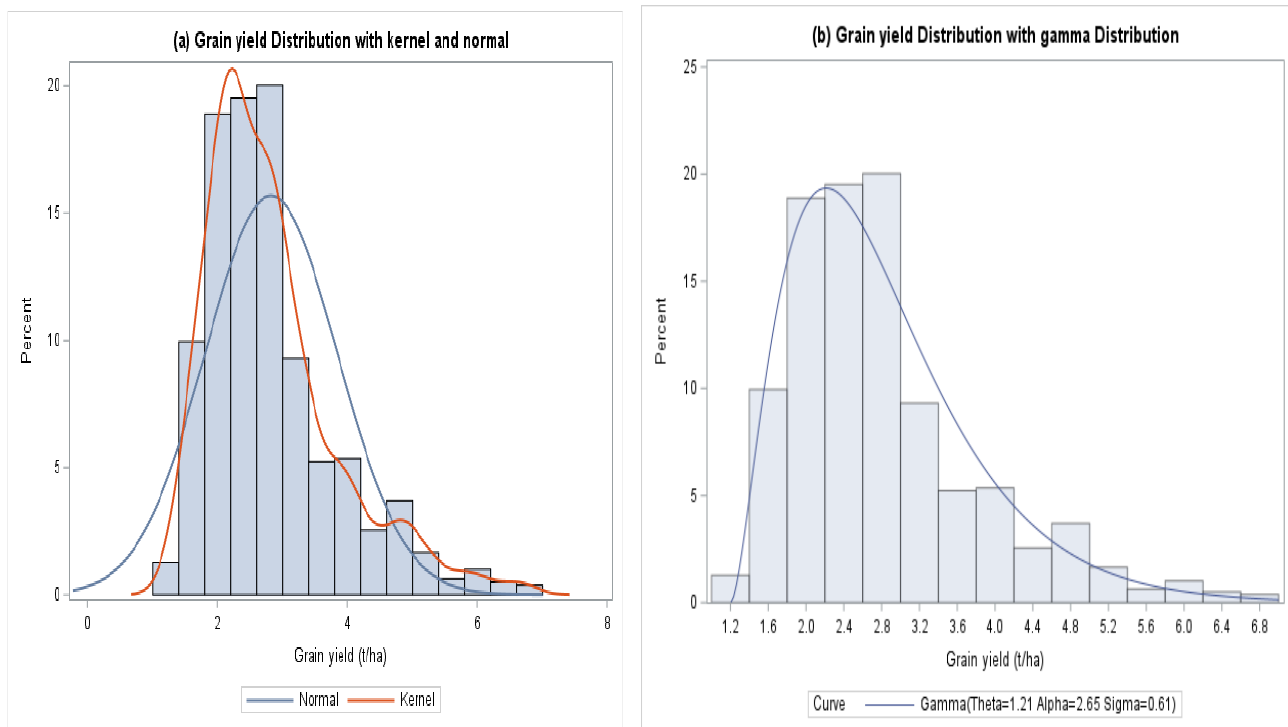
Figure 1. Histogram of Grain yield relative to kernel density and normal distribution ( a ) and the histogram of grain yield associated with the gamma distribution ( b ).